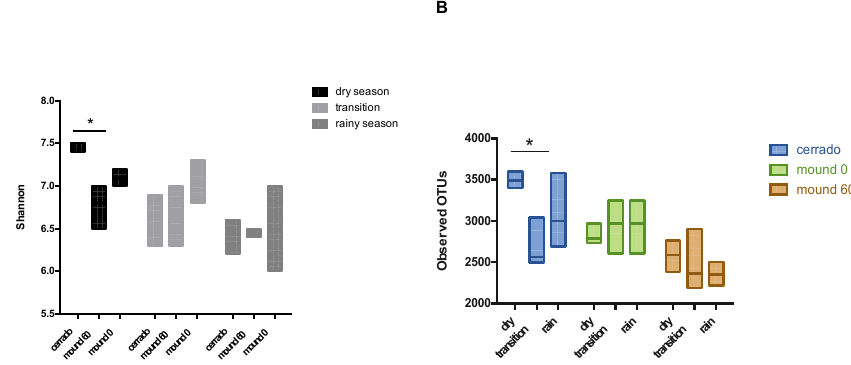
Figure 6. Diversity and richness measures for the microbial community for the Cerrado (50–60 cm), mound surface (0–10 cm), and mound soil (50–60 cm) samples collected in Brasilia, 2017 and 2018. ( A ) Shannon index values for microbial diversity. The dry, transition, and rainy seasons are shown by the grey scale bar. Significant values were considered for p value < 0.05 and are indicated with an asterisk ‘*’. ( B ) Analysis of the observed OTU number for each soil sample at the dry, early, and late rainy seasons. Statistically significant values were considered for p value < 0.05 and are indicated with an asterisk